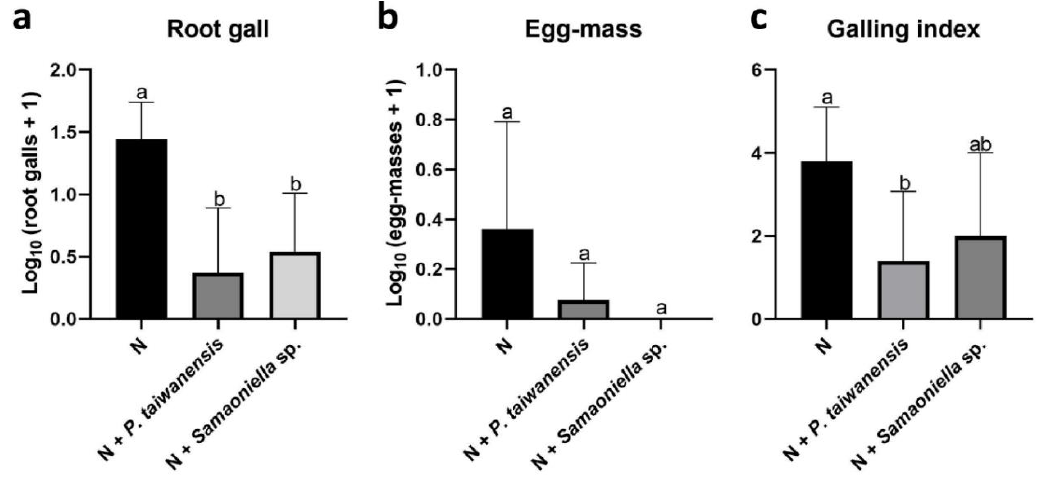
Figure 4. Effects of P. taiwanensis , Samsoniella sp. strain NTUCC 18–159, H. oviparasitica, and P. lilacinum strain 251 (PL251) on M. enterolobii in greenhouse trial 1. ( a ) root gall, ( b ) egg mass, ( c ) root galling index. N is the nematode-only treatment. Different letters indicate significant differences among treatments by Fisher’s LSD test ( P < 0.05), respectively.